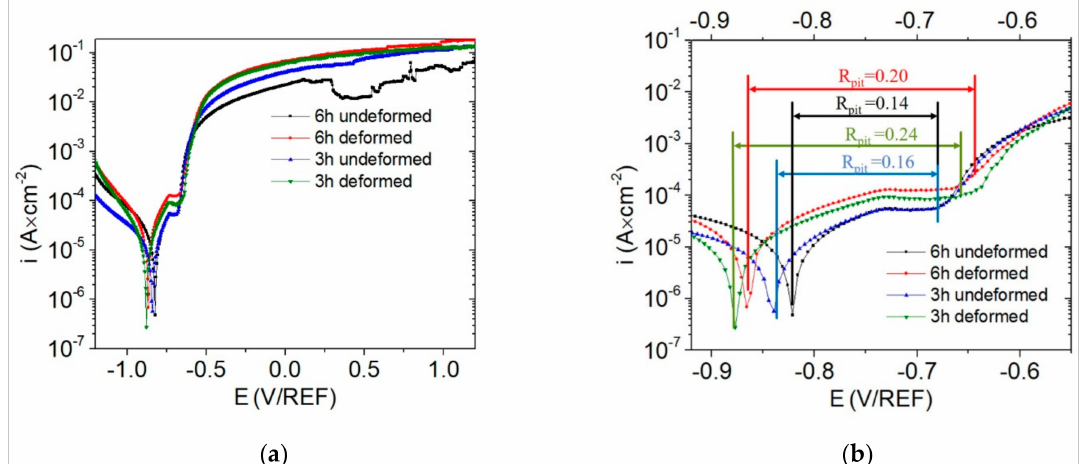
Figure 6. The electrochemical curves obtained after 3 and 6 h of immersion in 0.5 M NaCl (pH 3) for undeformed and deformed areas of the AA5754: ( a ), potentiodynamic polarization curves, and ( b ), pitting susceptibility of analyzed materials calculated using Formula